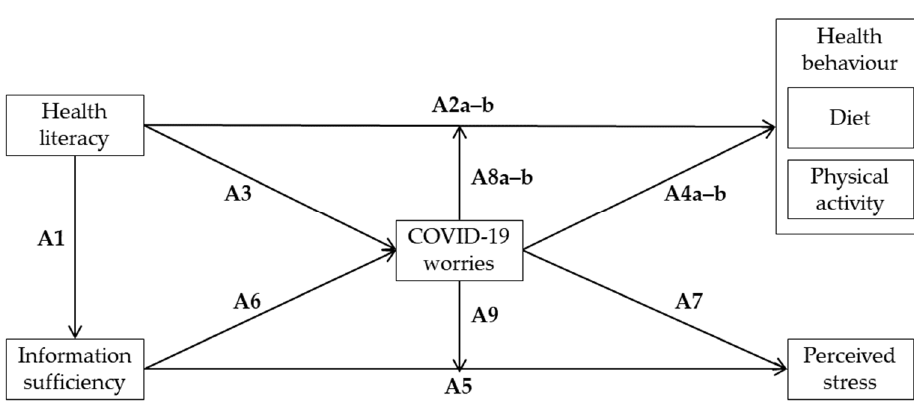
Figure 1. Overview of exploratory assumptions (own depiction).